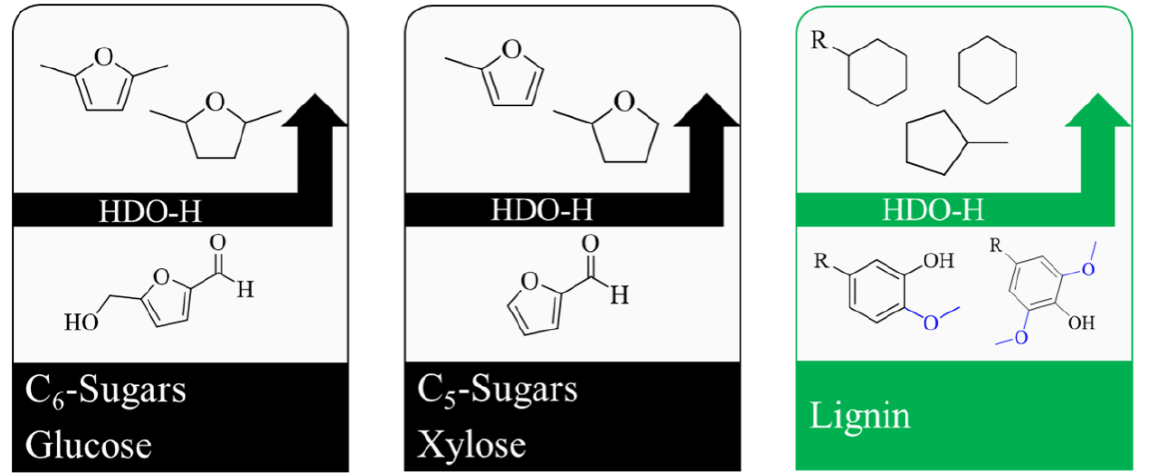
Figure 2. Hydrodeoxygenation/-hydrogenation (HDO-H) of lignocellulose-based functional mol- Hydrodeoxygenation/-hydrogenation (HDO-H) of lignocellulose-based functional ecules to emerging biofuels. molecules to emerging